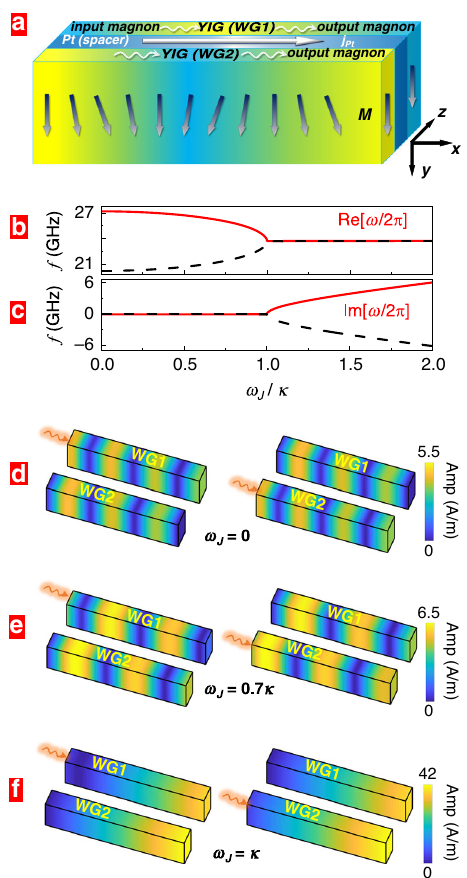
Fig. 1 PT symmetry. a Two magnetic layers (for example, YIG fi lms) serve as magnonic waveguides labeled WG1 and WG2. The interlayer coupling is mediated by a metallic spacer with a large spin-Hall angle (for instance, Pt spacer). Driving a charge current j Pt along the spacer ( x direction) results in spin-Hall torques acting on the magnetic waveguides. The torques damp or antidamp the magnetic dynamics in WG1 and WG2 resulting so in a PT- symmetric structure that exhibits special features of magnon propagation and magnetic permeability. Magnon wave packets launched locally at one end of WG1 or WG2 (left side in the fi gure) are steered, ampli fi ed, or suppressed by external fi elds that tune the waveguides from the PT- symmetric to the PT-symmetry broken phase at the exceptional point, where magnetic losses in WG1 balance magnetic antidamping in WG2. This is achieved for instance, by changing the ratio between the waveguides' coupling strength κ and the magnitude of the spin-Hall torques ω J . b Real and c imaginary parts of two magnon eigenmode frequencies f = ω /(2 π ) as we scan ω J / κ for the wave vector k x = 0.1 nm − 1 . d – f Spatial pro fi les of propagating spin-wave amplitude for a different loss/gain balance. The color change from blue to red corresponds to a linear amplitude change ranging from 0 to the maximum input signal. The local microwave fi eld excites spin waves at the left side of the waveguide and has a frequency of 20 GHz. The length (along x axis) of waveguides in d – f is 580